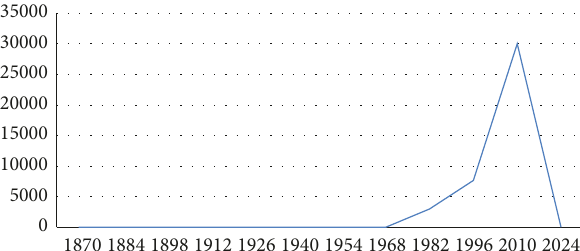
Figure 30: Article distribution by years for mixed-methods review articles.